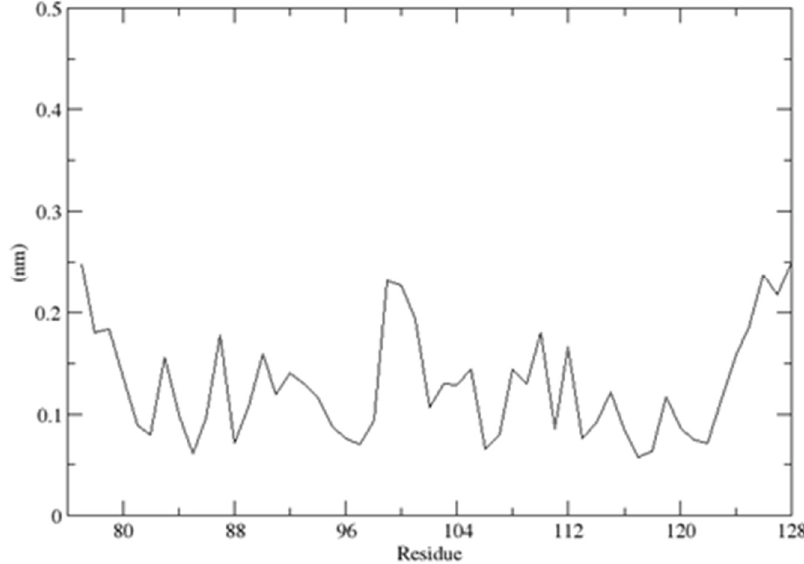
Figure 13. Mean fluctuation of individual CUBAN residues during the molecular dynamic simulation.